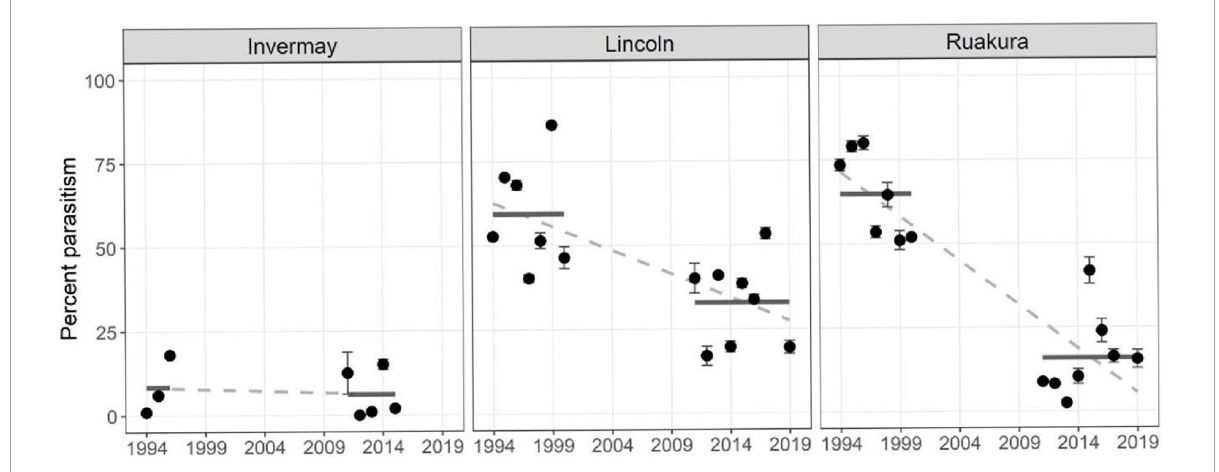
FIGURE1 Mean percent parasitism of diapausing Listronotus bonariensis (horizontal bars indicate mean during each period) in the Southern Region (Locality: Invermay), the Central Region (Locality: Lincoln), and the Northern Region (Locality: Ruakura) of New Zealand during the periods 1994–2000 and 2011–2019. Points ( • ) indicate annual mean overwintering parasitism rates. The slope of the dotted lines (—) indicate the Regional rates of parasitism decline. Error bars = standard error of the mean overwintering parasitism rate for each year.